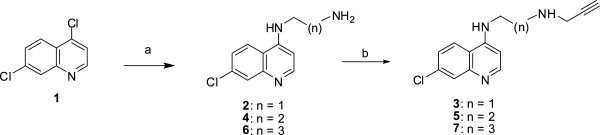
Reagents and conditions: (a) ethane-1,2-diamine, propane-1,3-diamine, or butane-1,4-diamine, 80°C for 1 h, 110°C for 4 h, 90%; (b) propargyl bromide, K2CO3, EtOH, 25°C, 48 h, 60%.